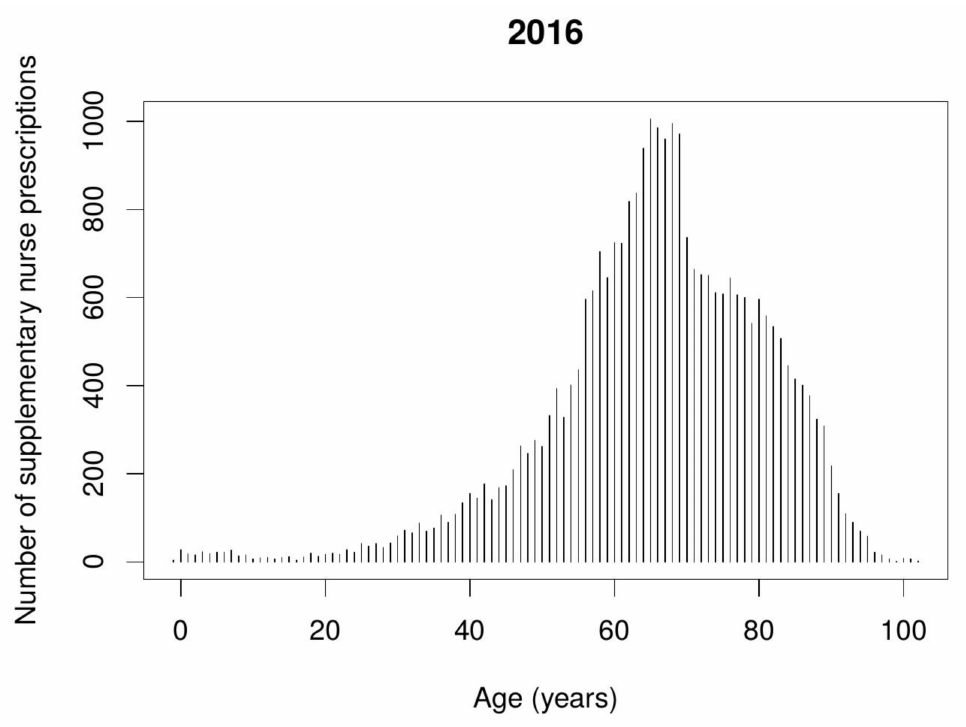
Figure 4. Number of nurse supplementary prescriptions depending on the patient’s age during the first year of implementing period.